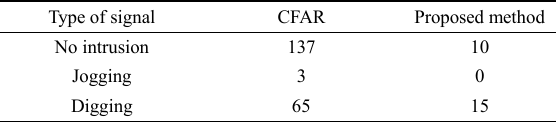
Table 5: Number of false alarms.